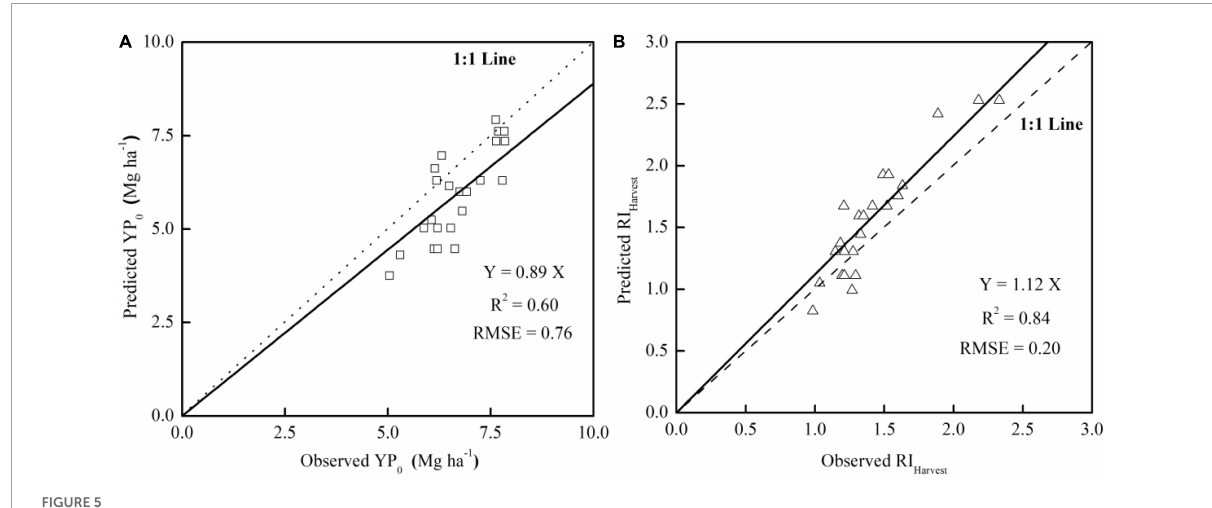
FIGURE5 Relationship between the observed and predicted YP 0 (A) and RI Harvest (B) in the validation field.